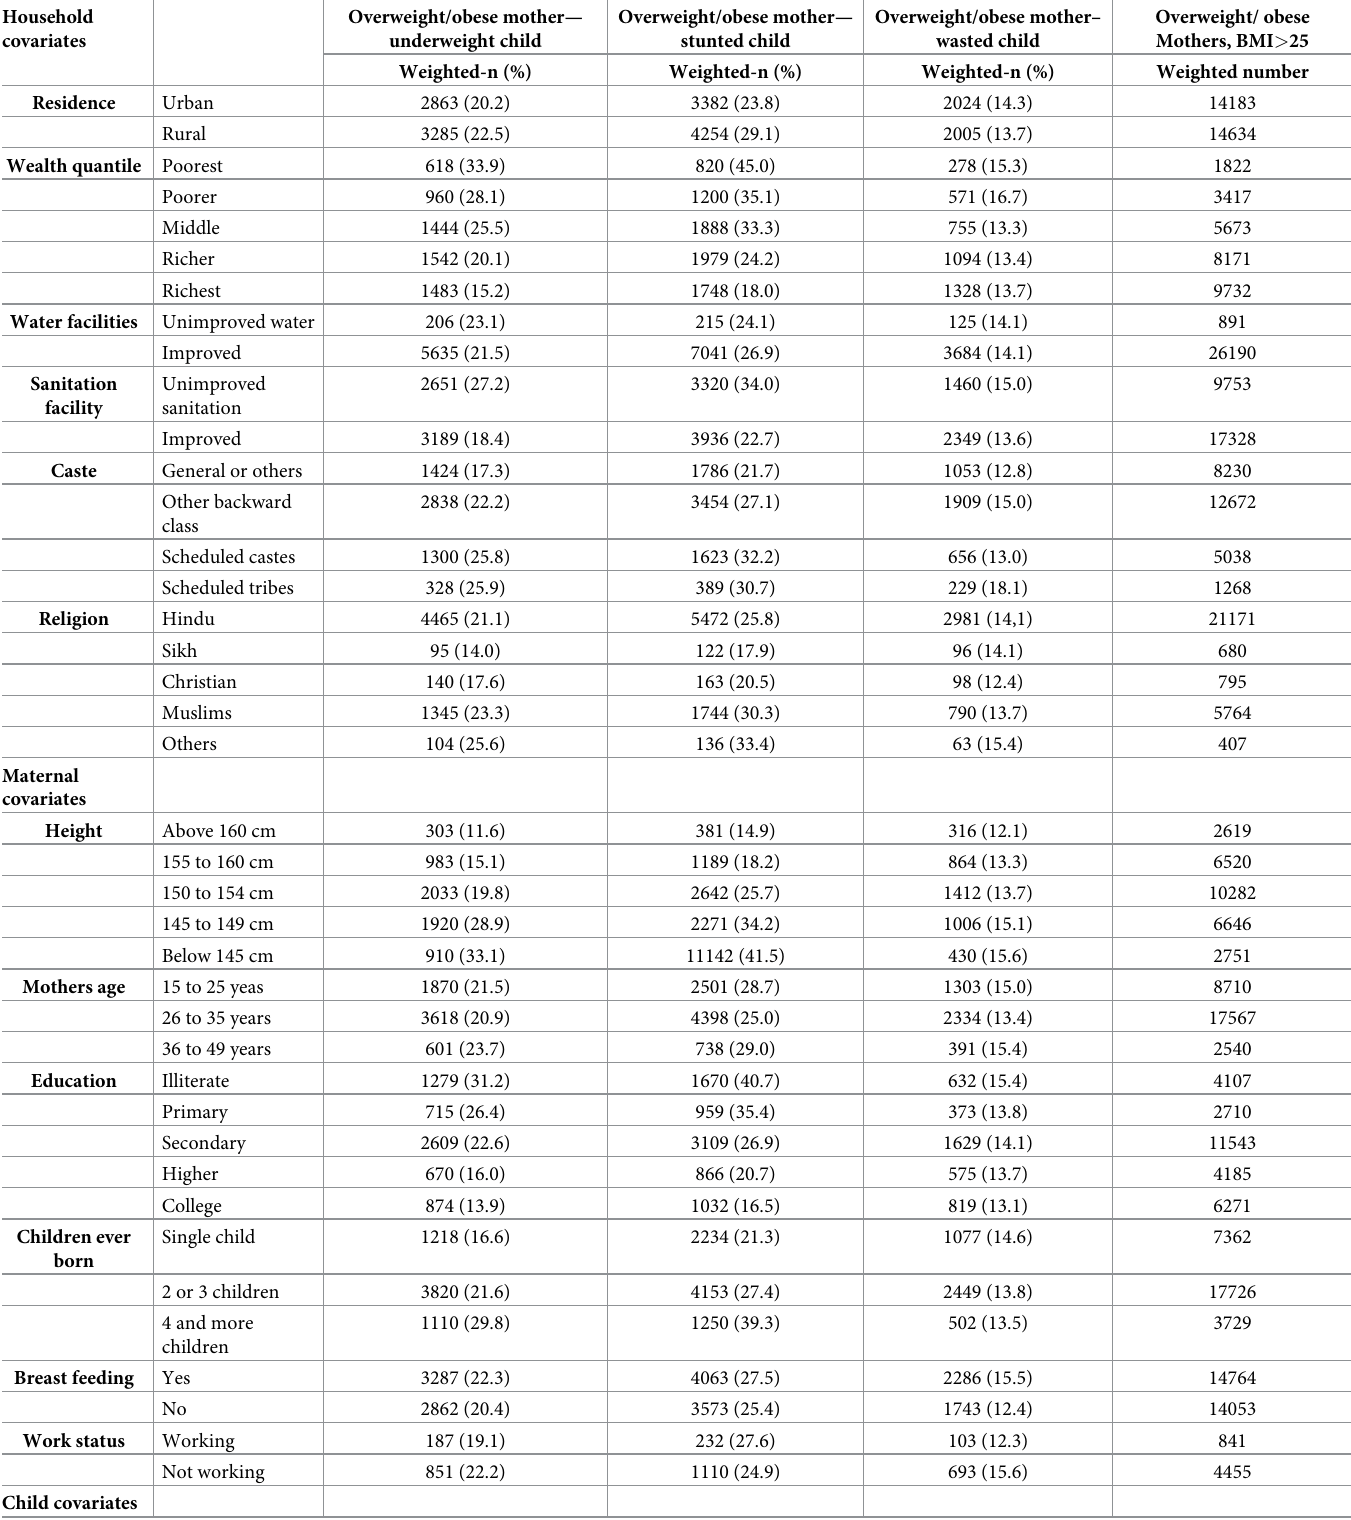
Table 2. Distribution of dual burden of malnutrition (overweight or obese mother and undernourished child) by familial, maternal and child covariates. Household